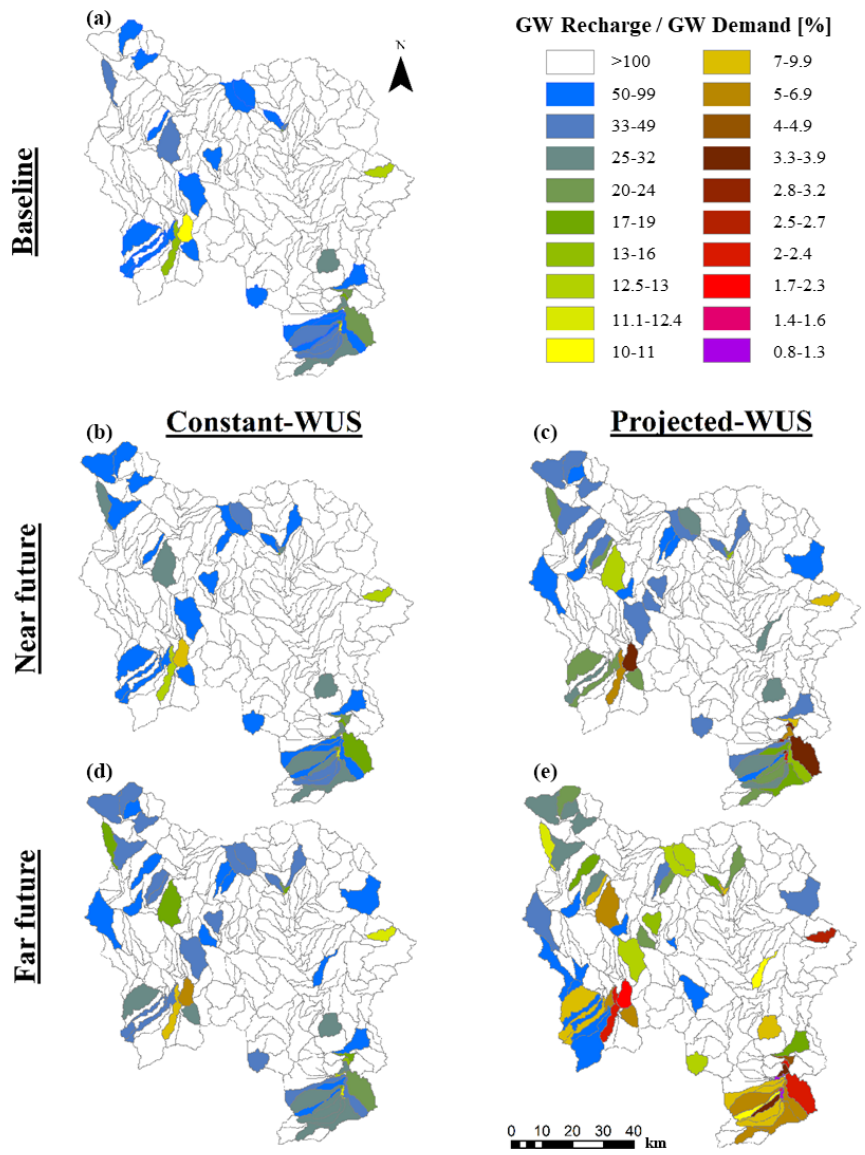
Figure 3. The percentage of groundwater demand that can be sustainably met by groundwater recharge at sub-basin scale under two different scenarios. Constant-WUS: the number of water use systems in the basin remain unaltered in the future. Projected-WUS: the number of water use systems increases linearly with population